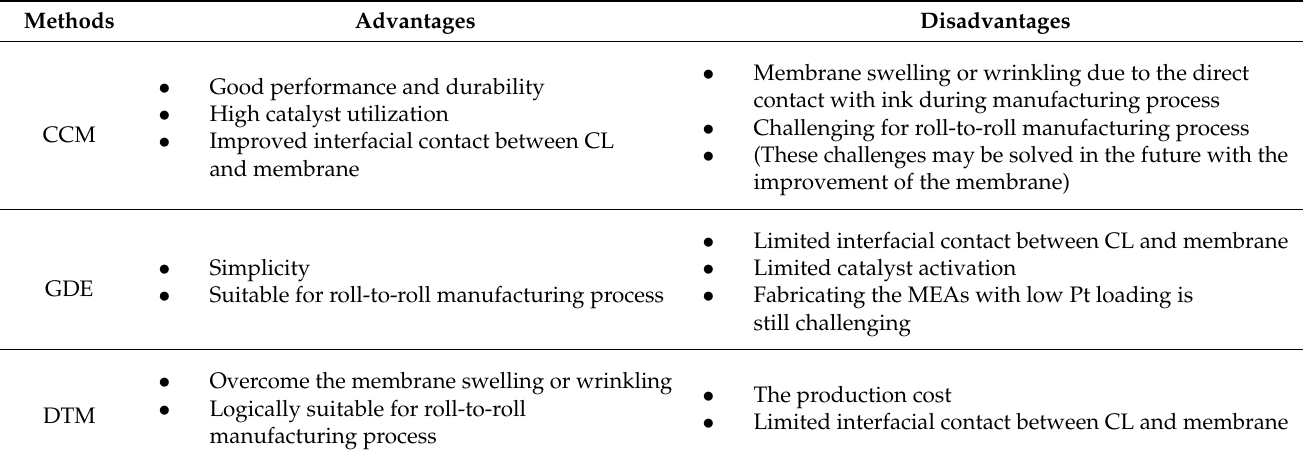
Figure 10. Three ways of fabricating catalyst coated membranes. Table 3. Comparison of CCM, GDE, and